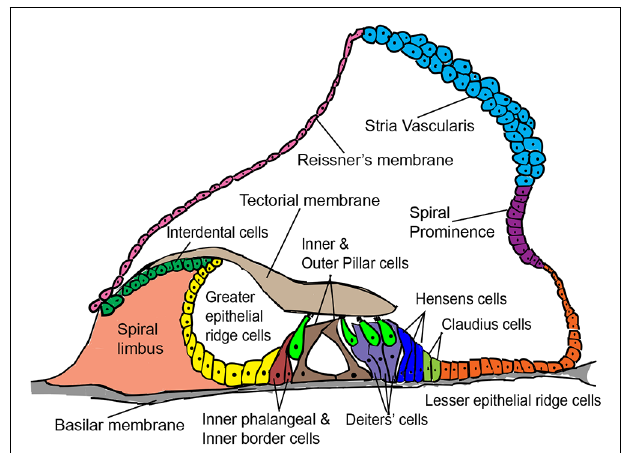
FIGURE 1 | Schematic cross-sectional view of the postnatal mammalian organ of Corti, denoting some structural features and a variety of cell types of interest for in vivo hair cell